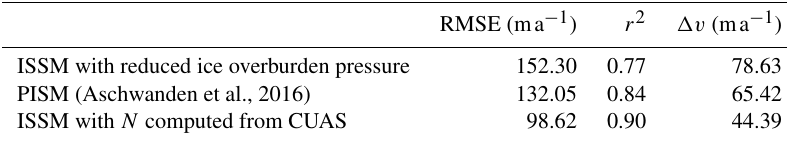
Table 4. Comparison of modeling results for horizontal ice velocity to observed values (Rignot and Mouginot, 2012). Herein RMSE denotes the root mean square error or L2-norm, r 2 is the Pearson correlation coefficient, and (cid:49)V is the